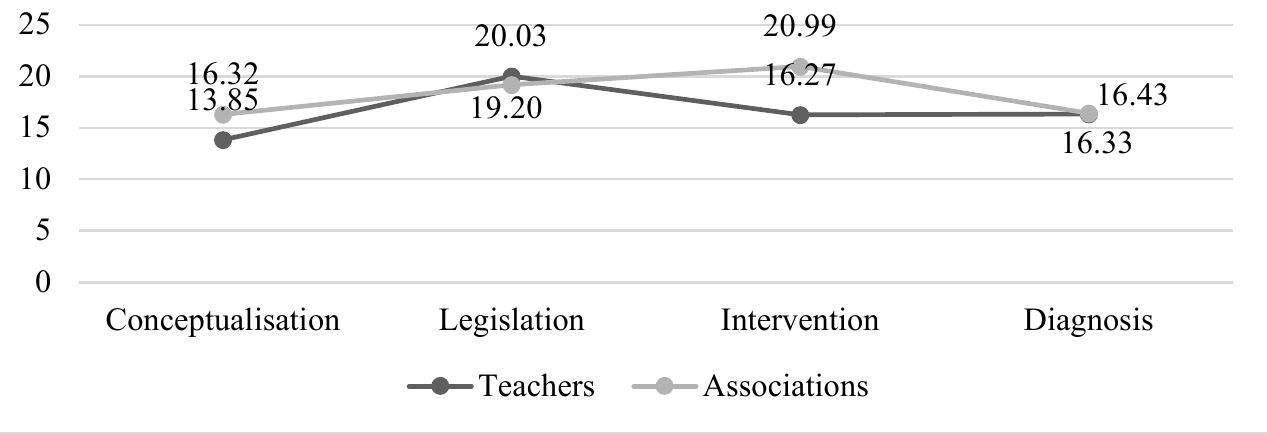
Figure 3. Mean scores for each dimension in the teachers and patient advocacy group questionnaires. Figure 3 suggests two patterns. Associations had higher mean scores than teachers in the conceptualisation and intervention dimensions (+2.47 and +4.72 points,